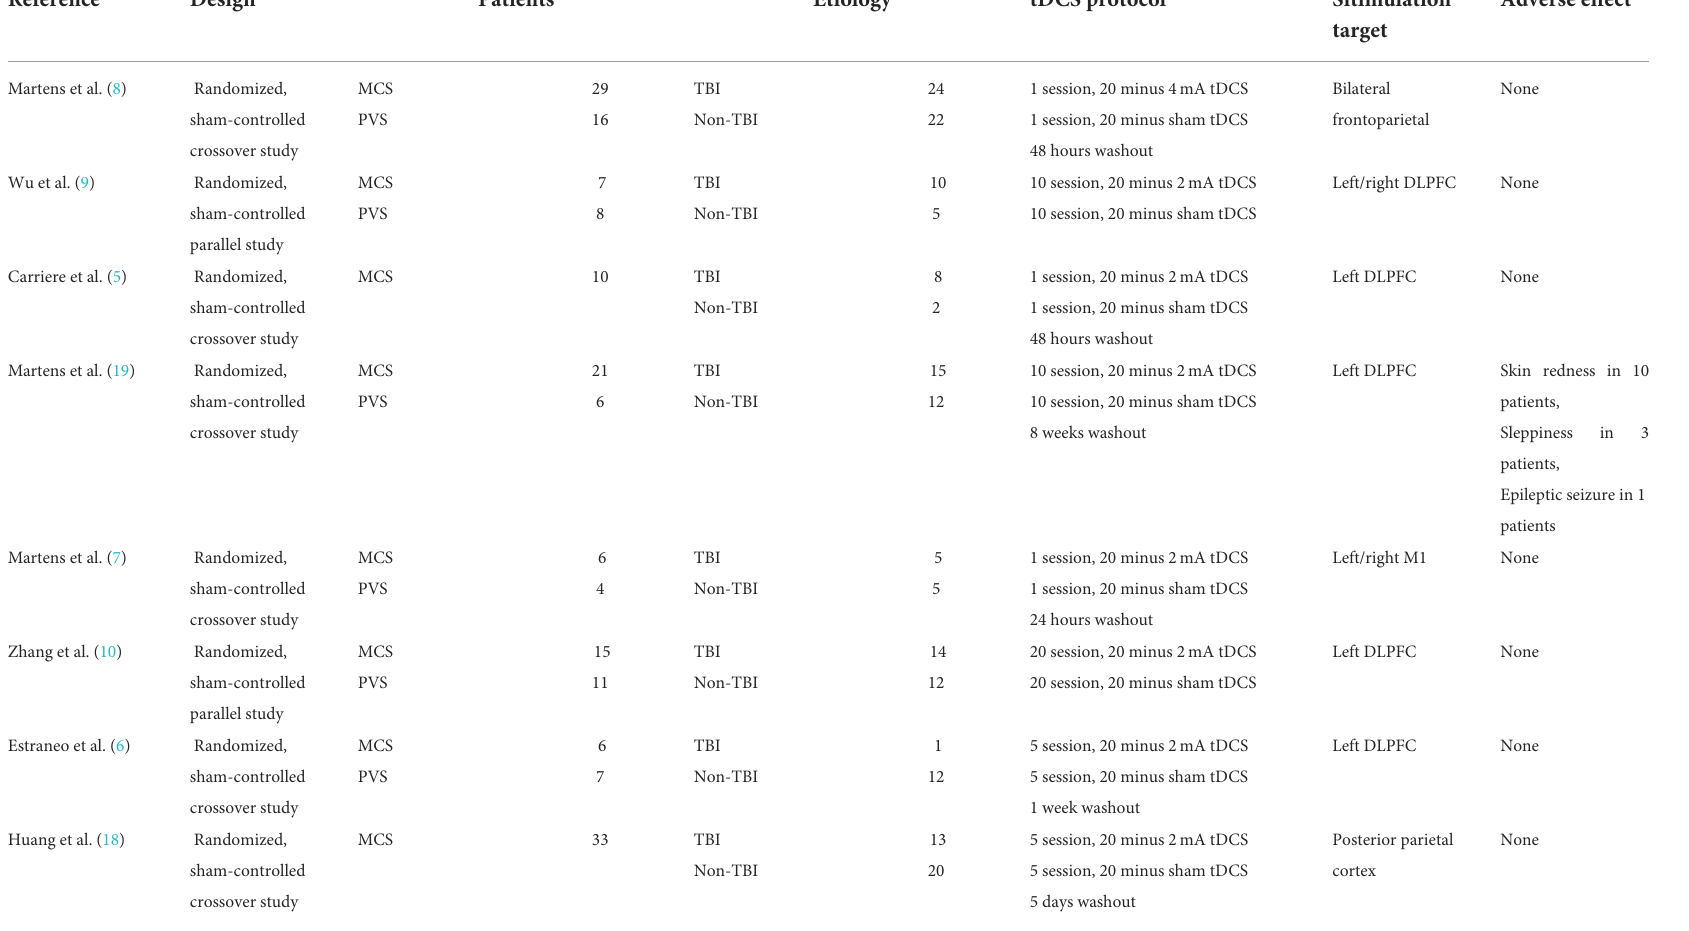
Individualpatientdatawereobtainedforalltrials.